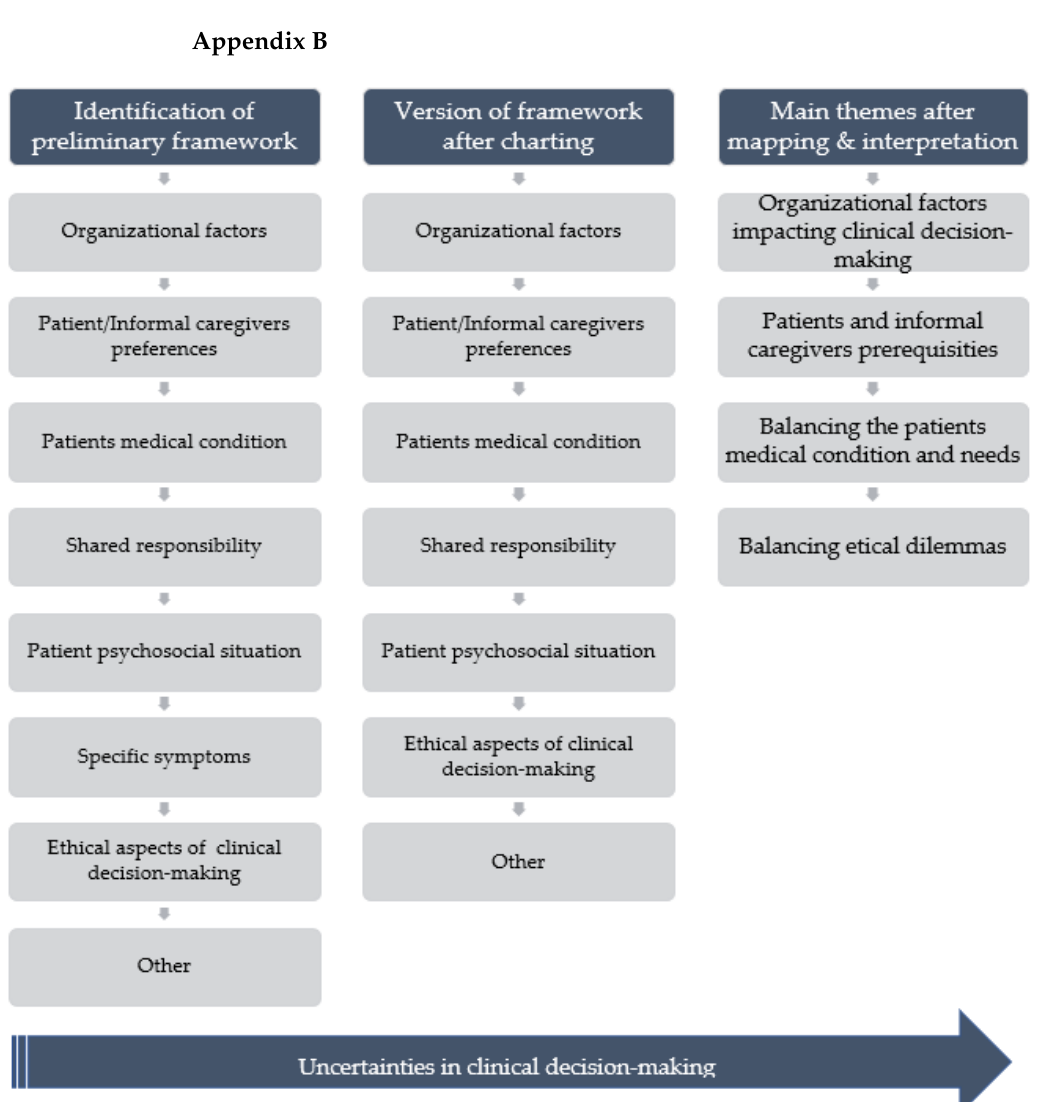
Figure A1. Development of preliminary framework into the main themes during the analytical process, the overarching theme identified in all themes.